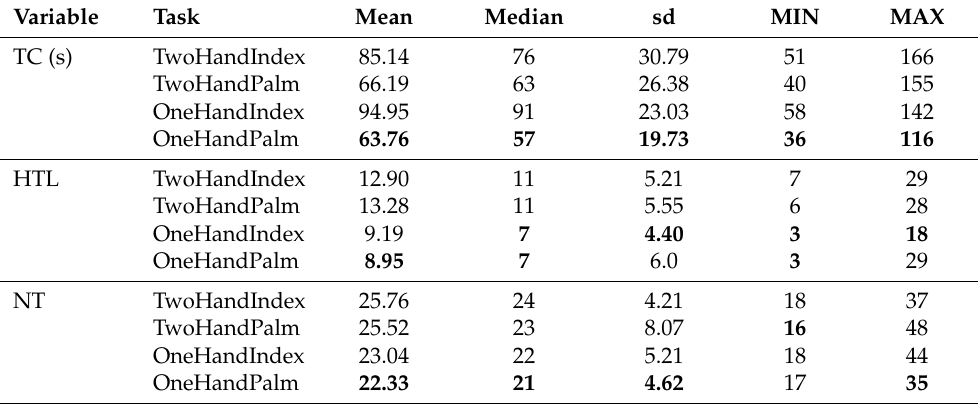
Table 1. Data collected during the evaluation. Task Completion Time (TC), number of times the hand tracking was lost during a session (HTL), and number of teleportations required to reach the goal (NT). Lower values are considered better, best values are marked in